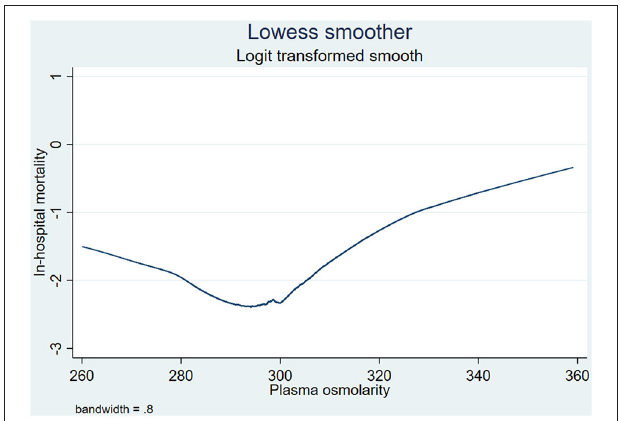
FIGURE 2 | Association between plasma osmolarity and in-hospital mortality presented through Lowess smoothing. Lowess, local weighted regression.